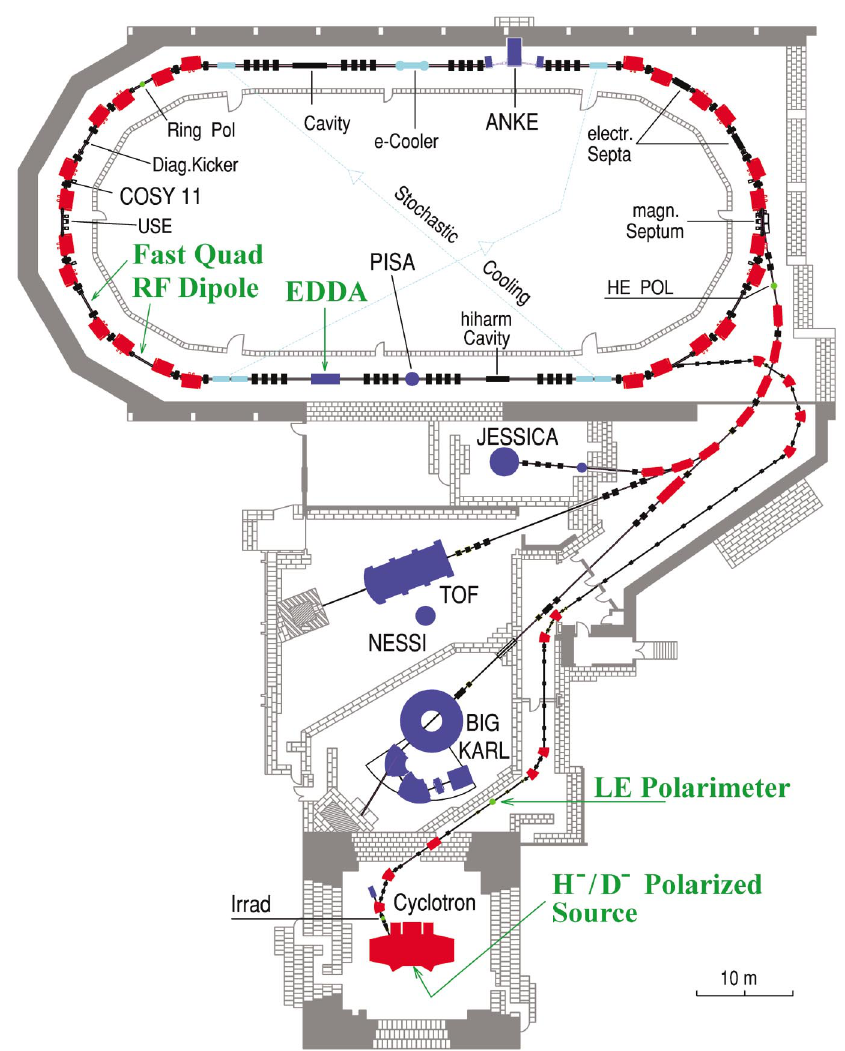
FIG. 1. (Color) Layout of the COSY storage ring, with its injector cyclotron and polarized ion source. Also shown are the rf dipole, the EDDA detector, and the low energy